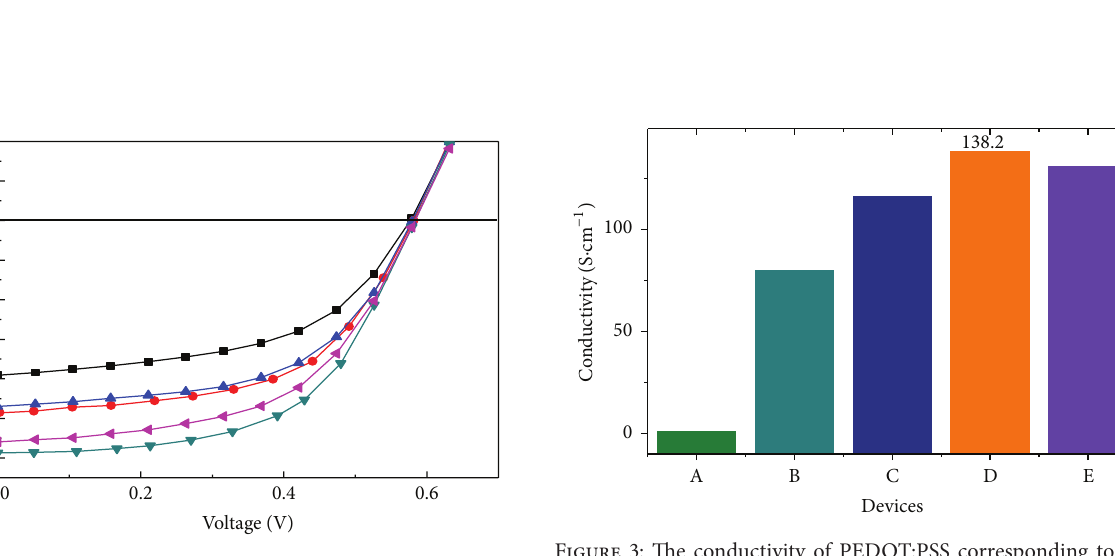
Figure 3: The conductivity of PEDOT:PSS corresponding to dif- ferent devices (A: only PEDOT:PSS solution on ITO at the speed of 3000 rpm. B: the PEDOT:PSS and DMAC mixed in a ratio of 4 :1(v/v) at the speed of 3000 rpm. C, D, and E: the PEDOT:PSS buffer layer modified by DMAC at speed of 1000, 3000, and 5000 rpm).